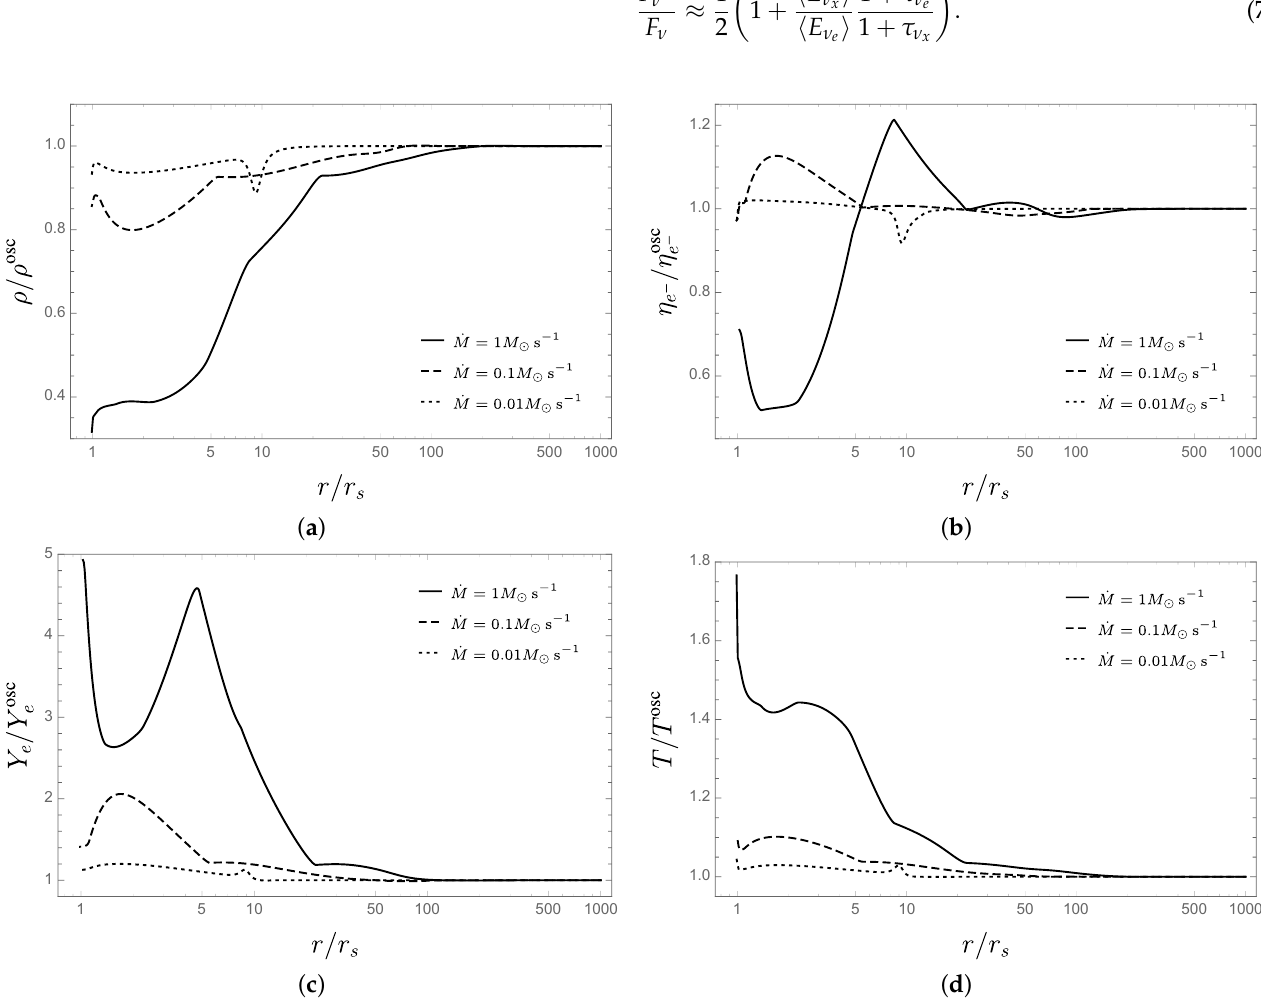
Figure 8. Comparison between the main variables describing thin disks with and without a neutrino flavor equipartition for each accretion rate considered. Here ρ osc , η osc , Y osc e , T osc are the density, electron degeneracy, electron fraction and e − temperature of a disk with a flavor equipartition. Together with Figure 3, these plots completely describe the profile of a disk under a flavor equipartition. ( a ) The ratio between baryon densities. ( b ) The ratio between degeneracy parameters. ( c ) The ratio between electron fractions. ( d ) The ratio between